Question: Which visualization type does this figure use?
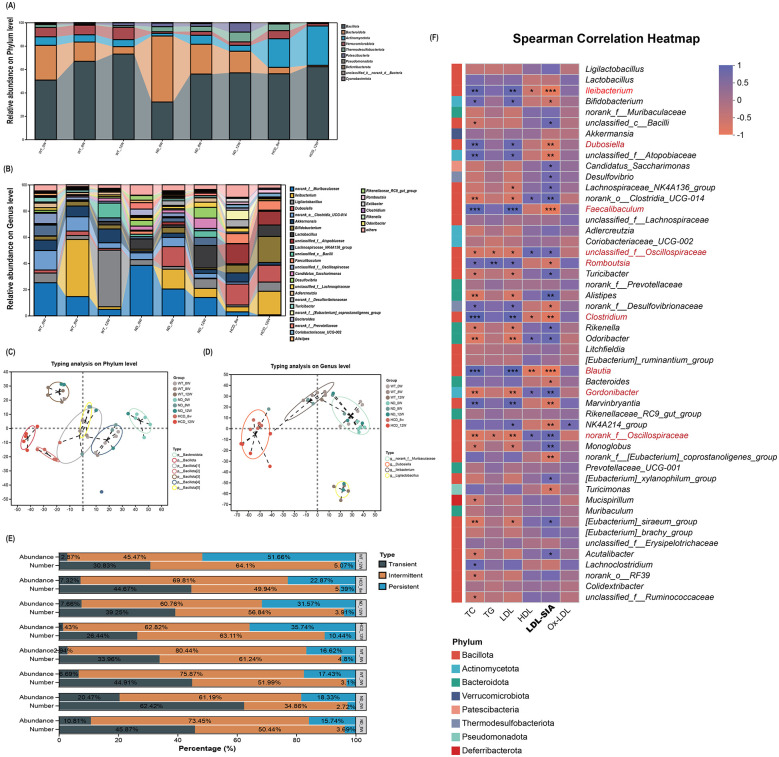
Answer: heatmap